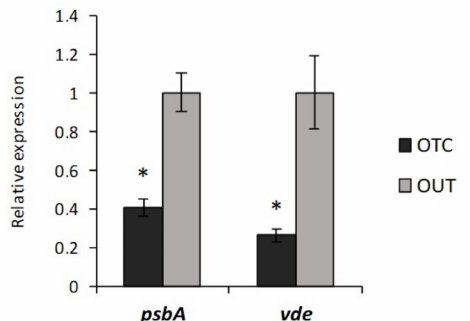
Figure 5. Relative expression of C. quitensis genes normalized with G6PDH and PP2Acs genes. psbA : PSII protein D1; vde : violaxanthin de-epoxidase. Data represent the mean ± SD from three biological and three technical replicates. Asterisks indicate significant differences (Student t -test * p ≤